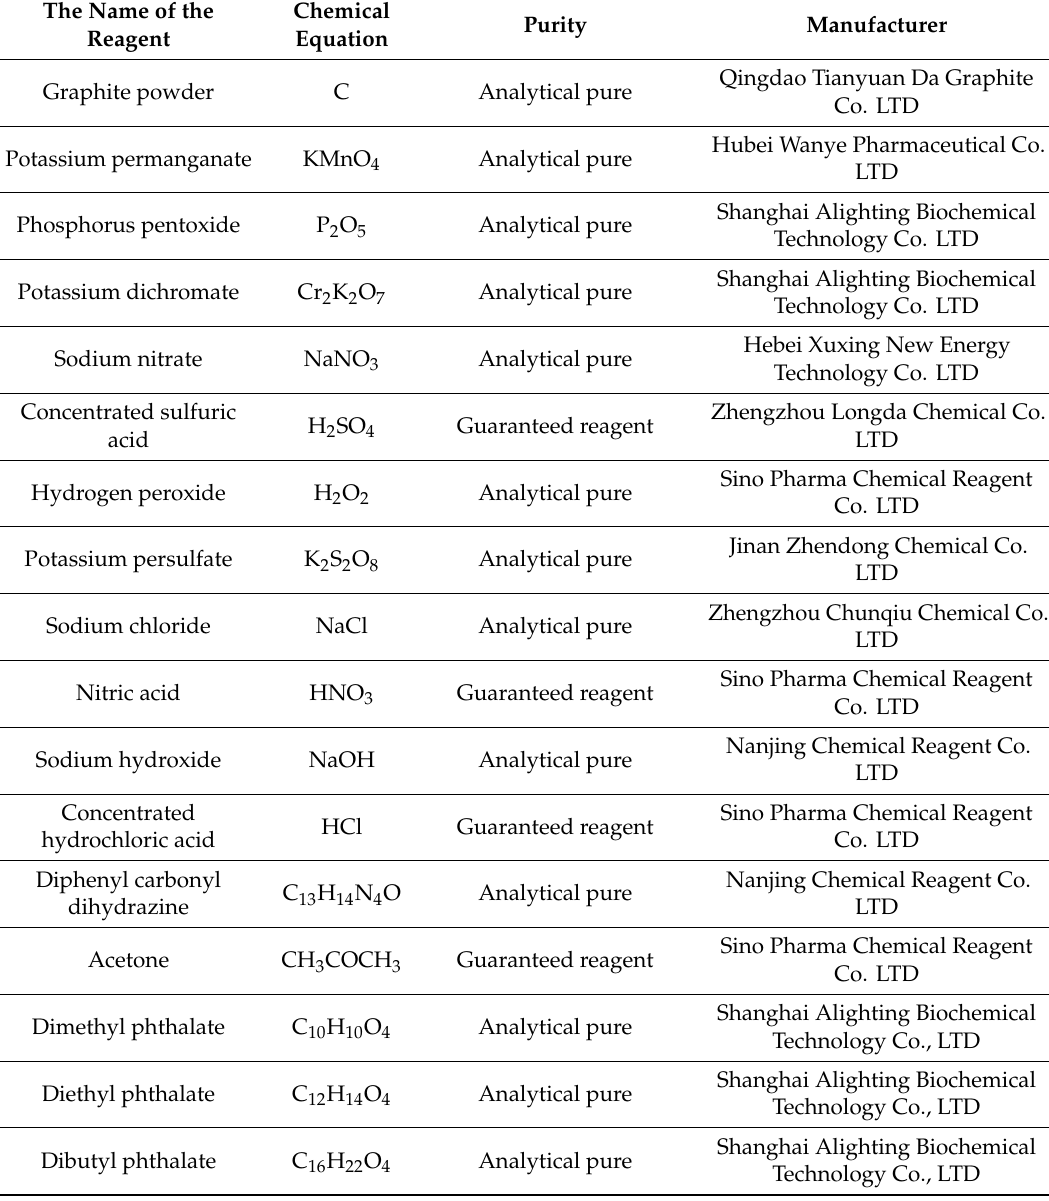
Table 1. The reagent used in this